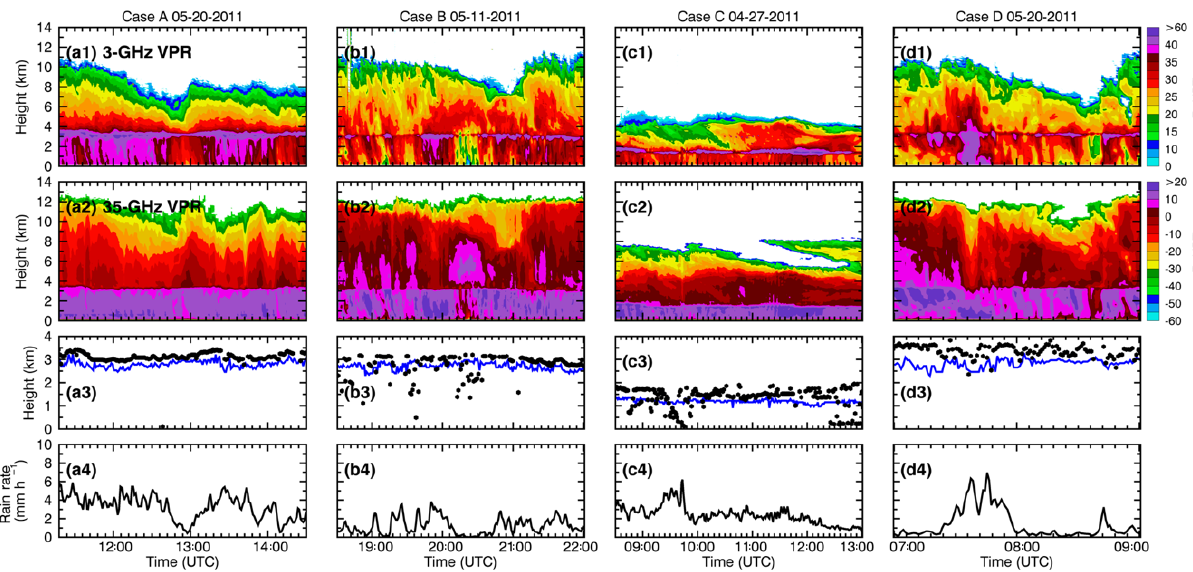
Figure 1. Time series of (a1) radar reflectivity ( Z e ) from NOAA 3GHz vertical pointing radar (VPR), (b1) radar reflectivity from ARM 35GHz VPR, (c1) melting base (blue lines) and cloud base (black dots), and (d1) rain rates from RD-80 surface disdrometer measurement for Case A (20 May 2011, 11:20–14:30UTC); (b1) – (b4) for Case B (11 May 2011, 18:30–22:00UTC); (c1) – (c4) for Case C (27 April 2011, 08:30–13:00UTC); (d1) – (d4) for Case D (20 May 2011, 07:00–09:00UTC). Note that the ranges of radar reflectivity values are different in 3 and 35GHz